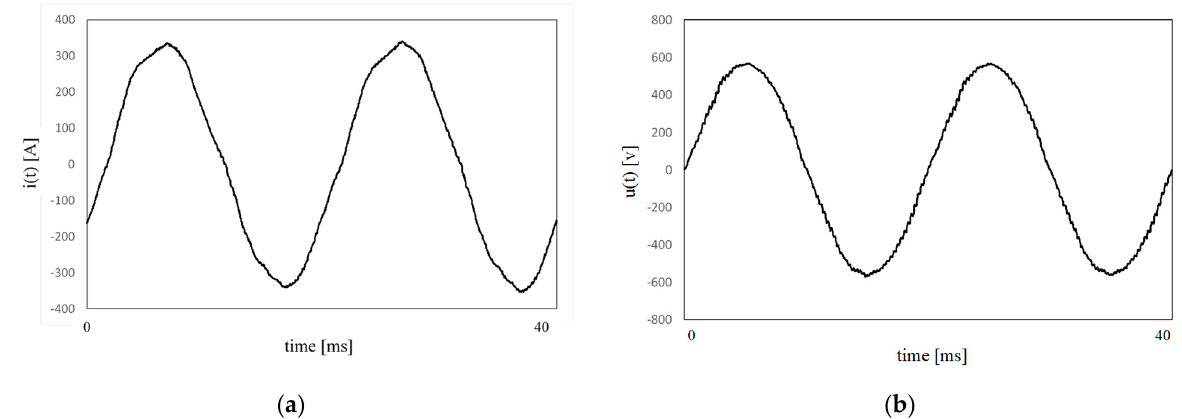
Figure 2. ‘Active Front End’ input current and voltage waveforms at main bus bars.